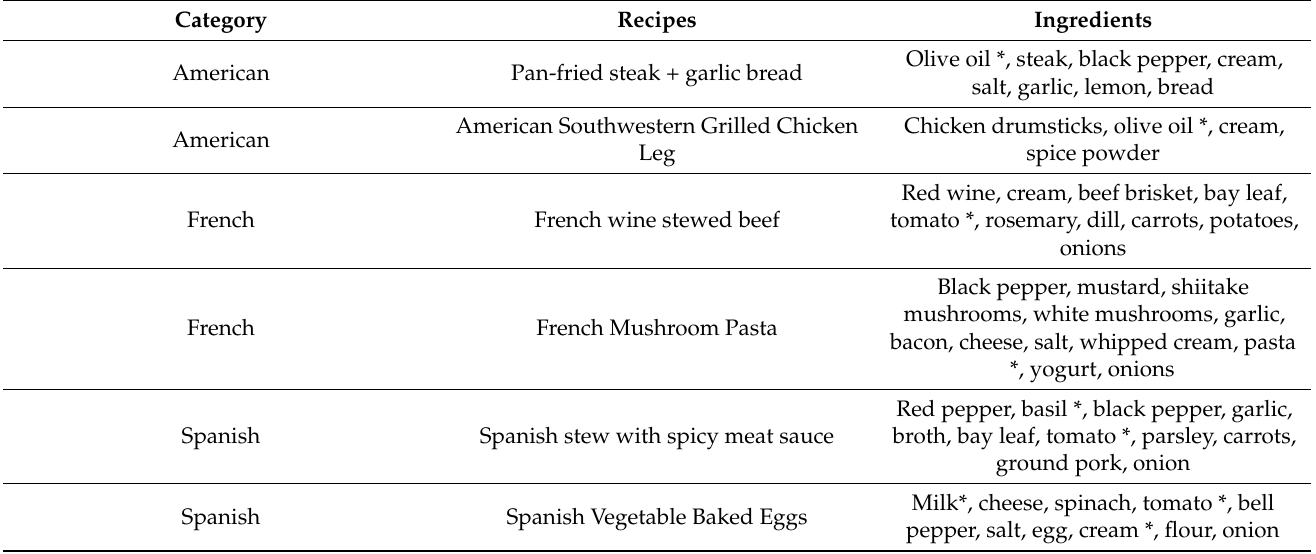
Table 12. Examples of recipes that are misclassified as Italian.